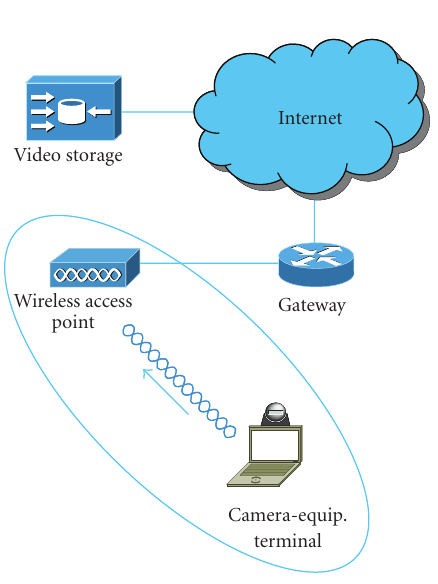
Figure 1: The scenario under consideration.